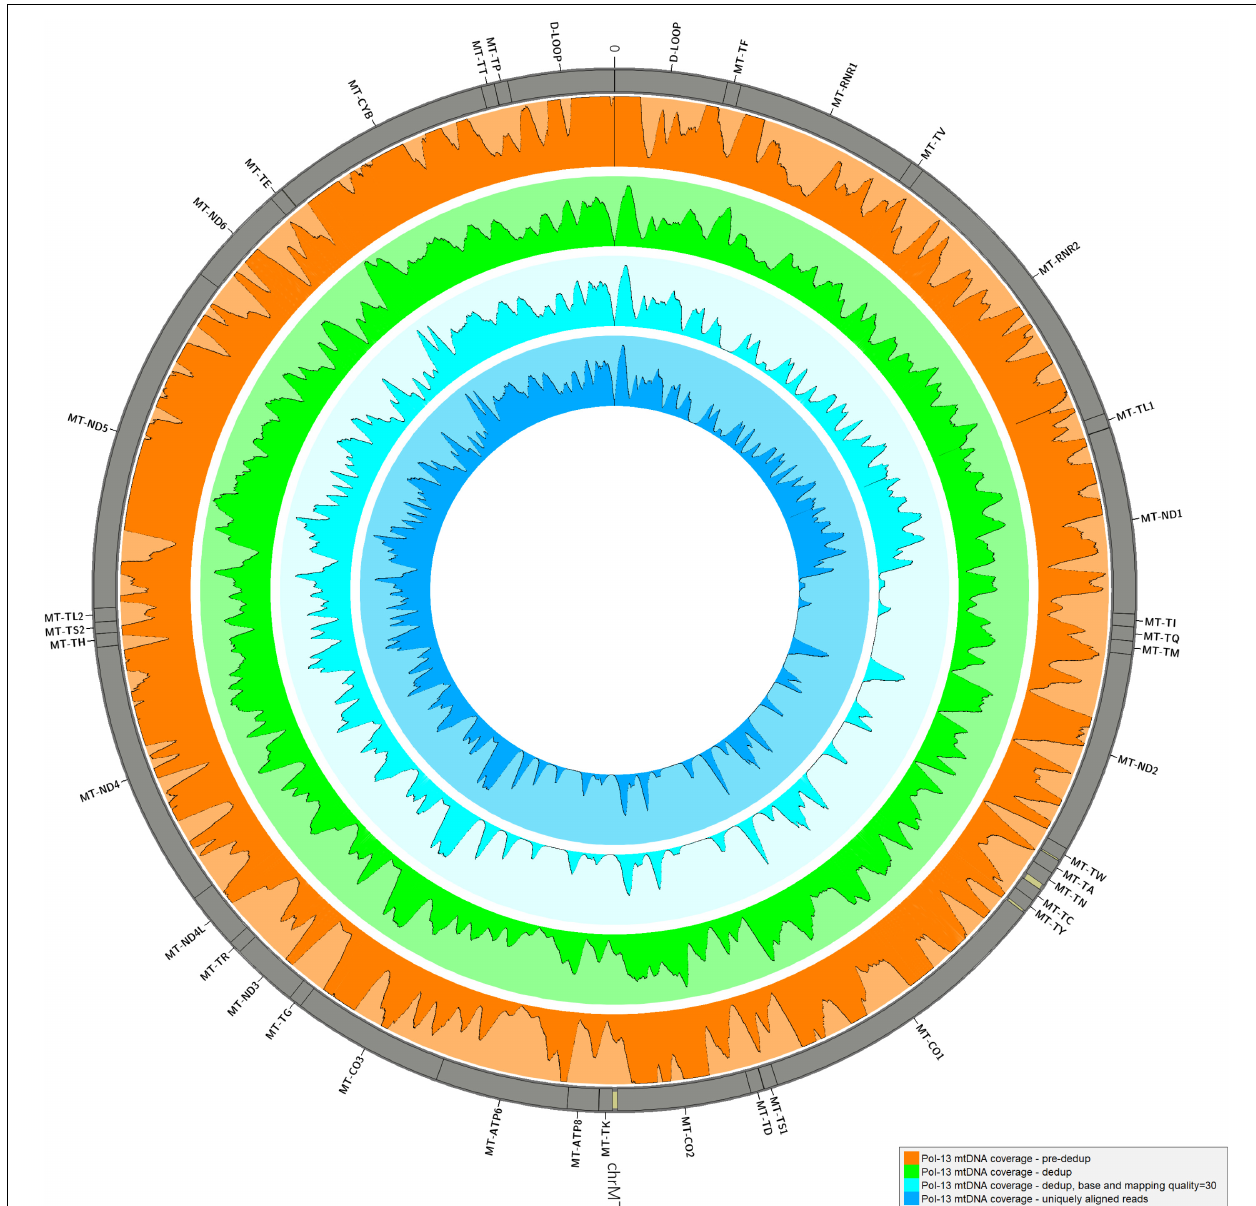
FIGURE 3 | Mean depth of coverage in Pol-13 sample. The mean per base depth of coverage was calculated for Pol-13 alignment at different steps of the pipeline: before and after duplicate removal, filtering by base and mapping quality ( ≥ 30), removing all reads ambiguously mapped. Minimum depth in each histogram = 0, maximum depth = 2,000. The graph was generated by Circos (RRID:SCR_011798, v0.69-8) (Krzywinski et al.,